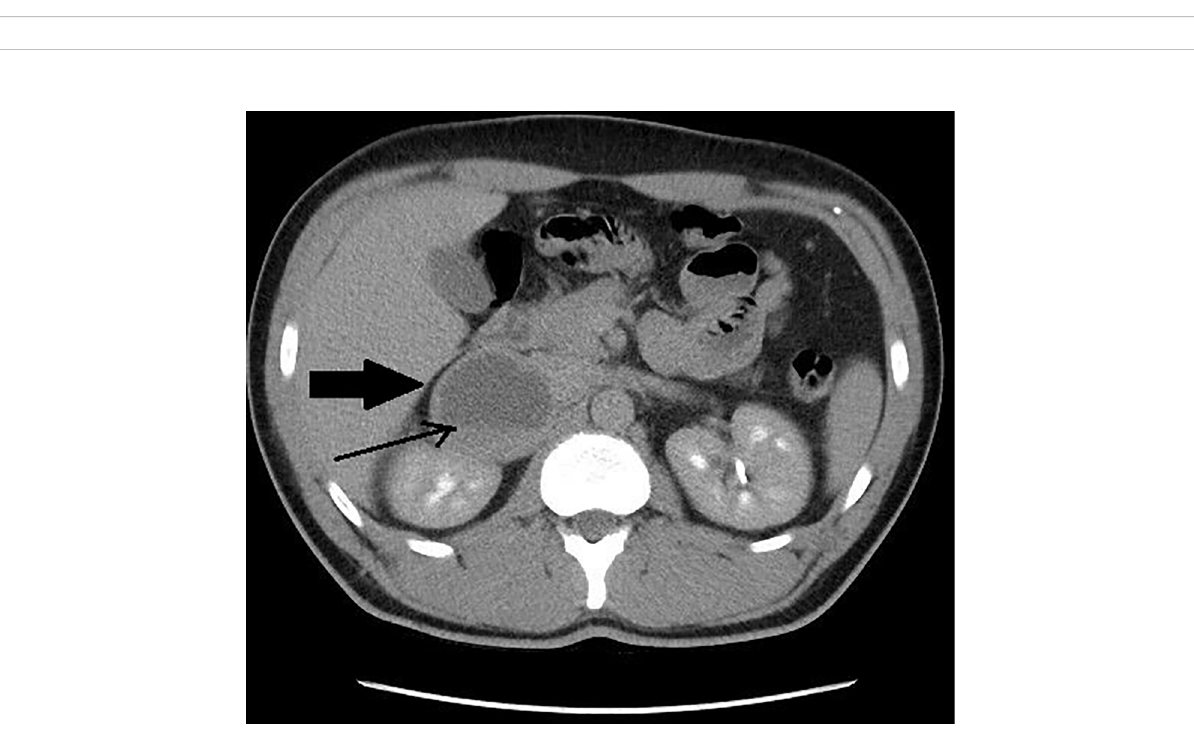
FIGURE 4 Patient number 7: CT of the abdomen, venous phase, axial image – right adrenal lesion with solid-cystic appearance (thick arrow), central area of fl uid attenuation, with fl uid- fl uid level (thin